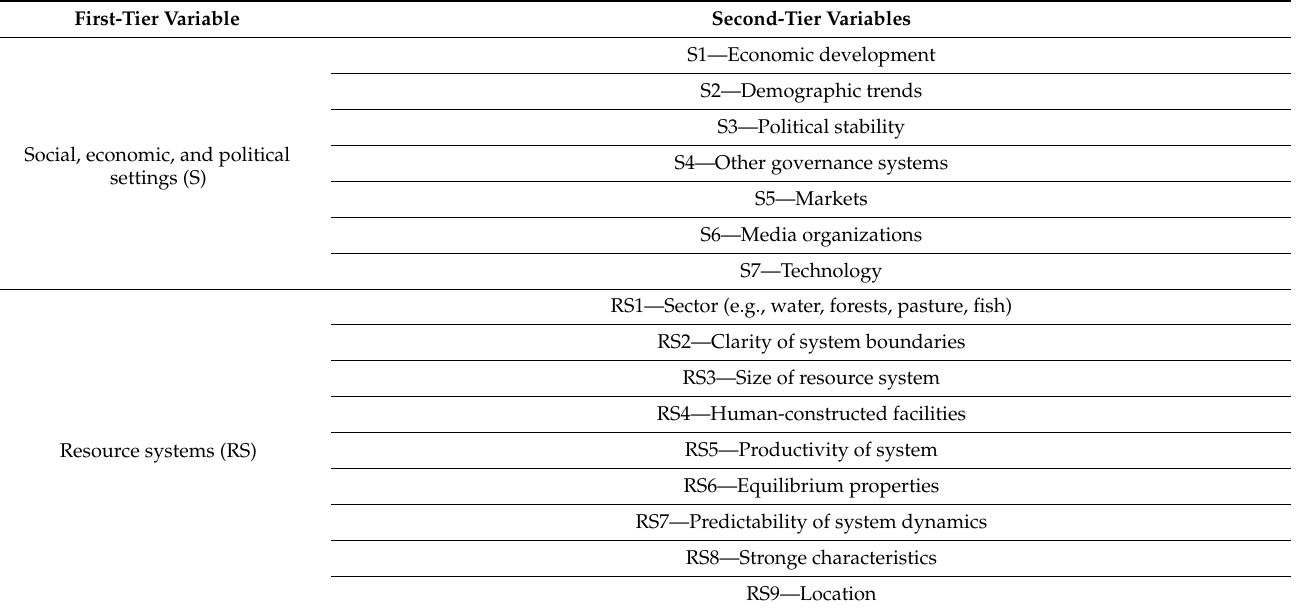
Table 1. Second-level variables of the SES framework.